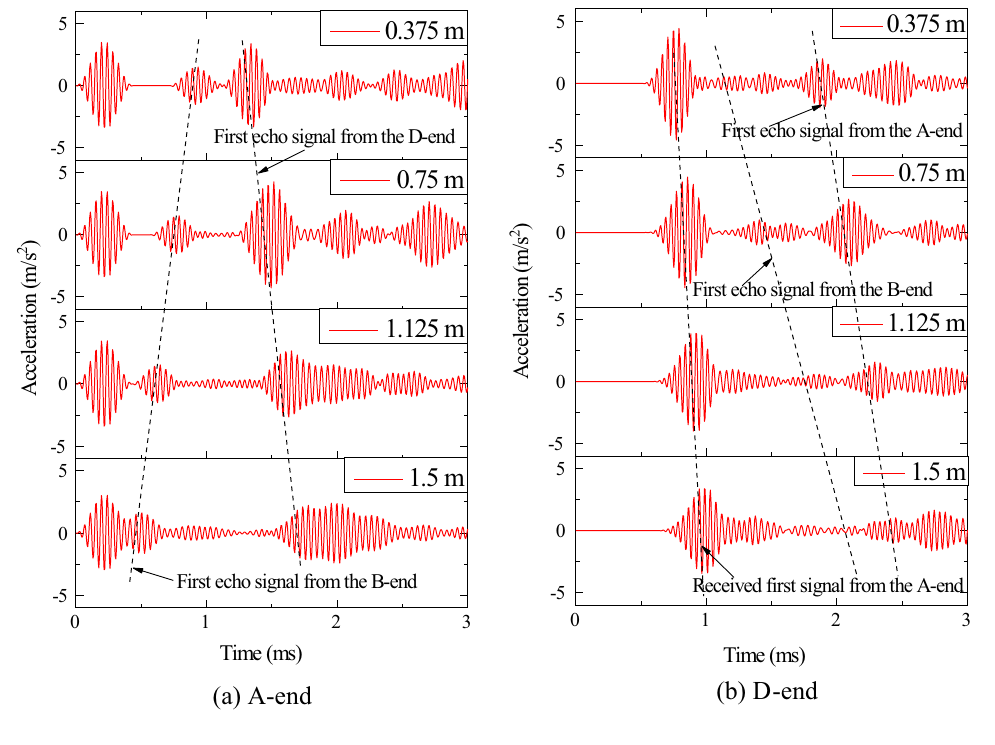
Fig. 12 Wave propagation in grouted rockbolt systems with different bond lengths